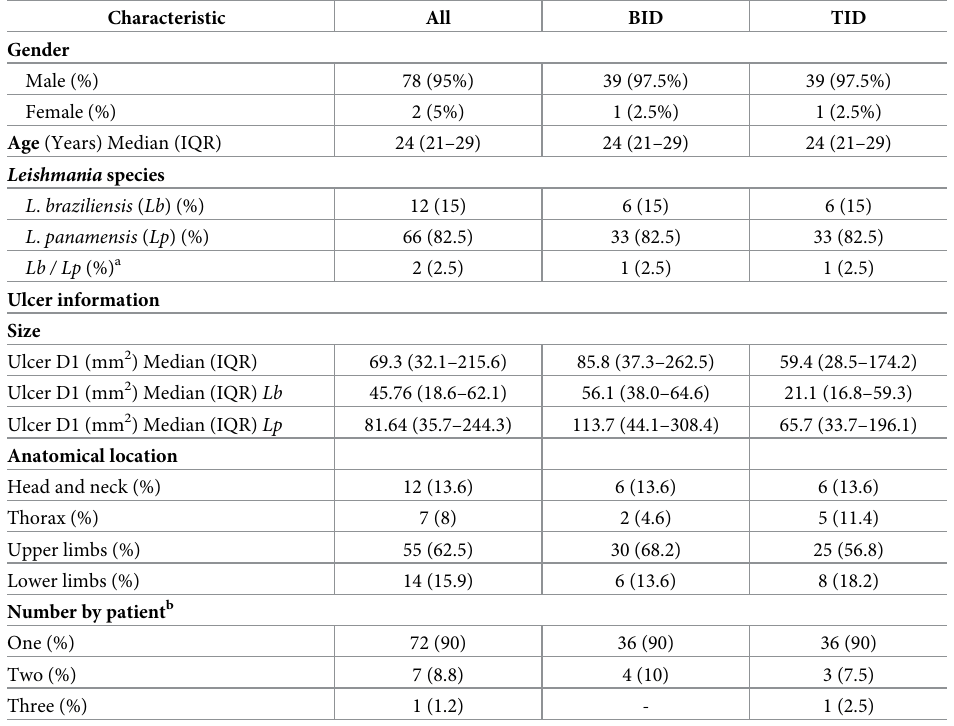
Table 1. Baseline characteristics of volunteers.